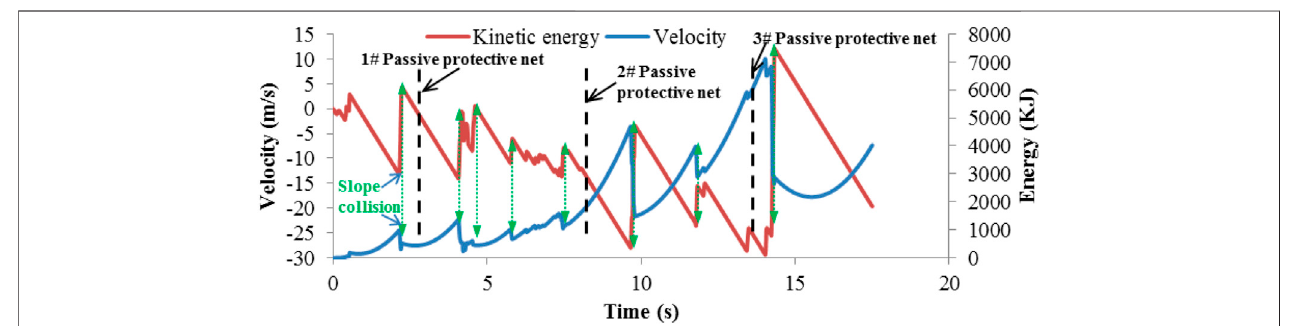
FIGURE 13 | Temporal variation of velocity in the Z -direction and kinetic energy of the rock block.